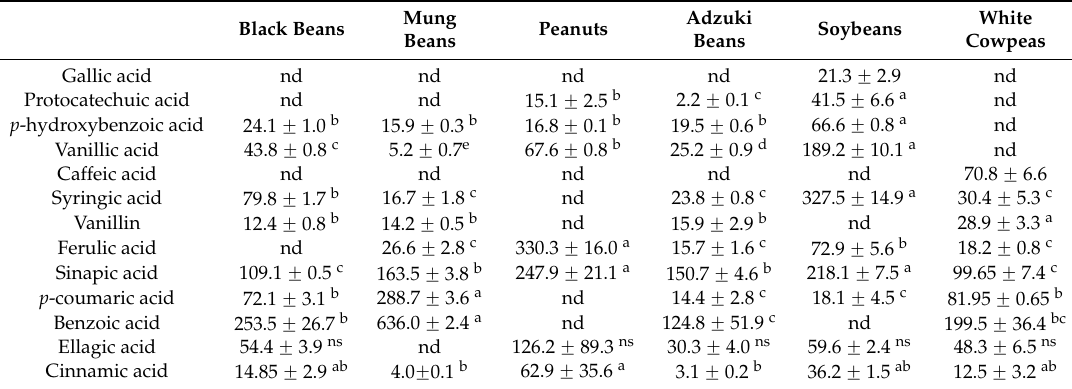
Phenolic components and concentrations ( µ g ¨ g ´ 1 dry weight) of legumes after 5-day